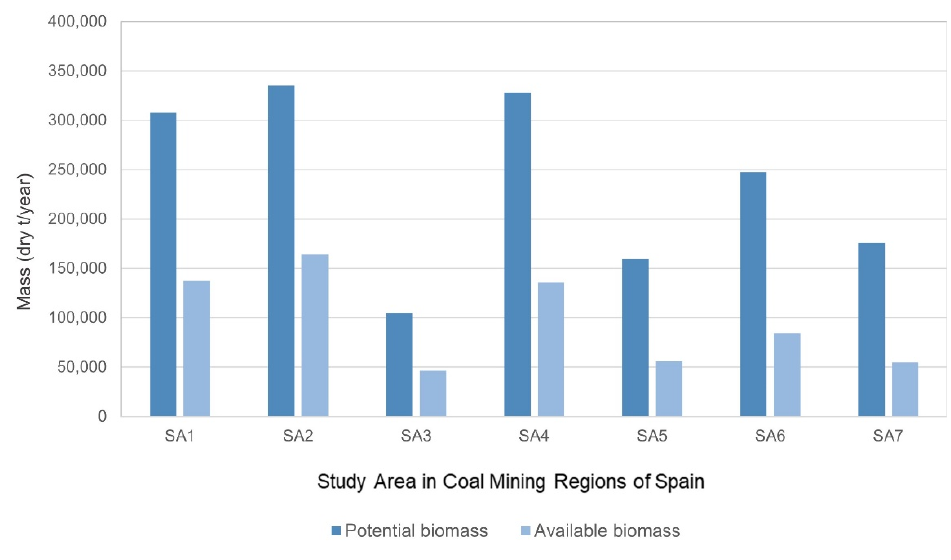
Figure 4. Distribution of the biomass resources in the study area by sector.